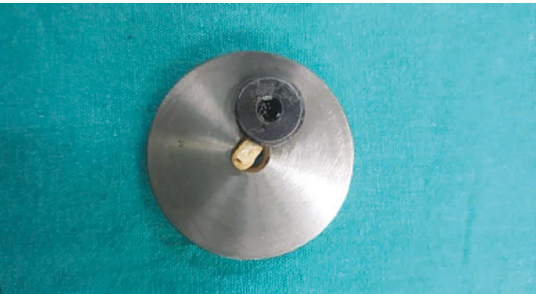
Figure 4: Metal base for samples to be placed on prior to push-out